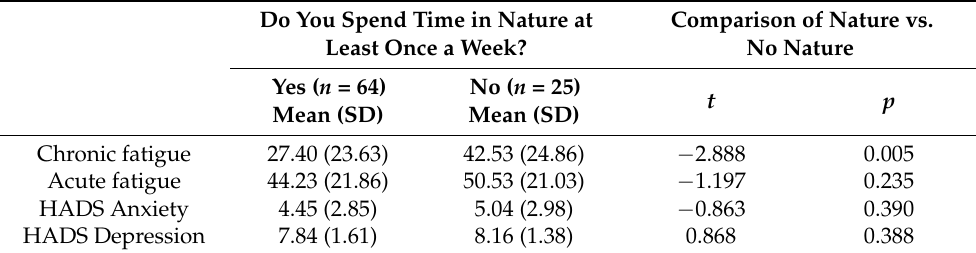
Table 2. Comparison of key outcome variables between participants who made weekly visits to nature, and those who did not. The results for chronic fatigue remain significant after applying a Bonferroni correction changes α to 0.05 ÷ 4 = 0.0125. HADS, Hospital Anxiety and Depression Scale. Do You Spend Time in Nature at Comparison of Nature vs. Least Once a Week? No Nature Yes ( n = 64) No ( n = 25) t p Mean (SD) Mean (SD) Chronic fatigue 27.40 (23.63) 42.53 (24.86) 0.005 Acute fatigue 44.23 (21.86) 50.53 (21.03) 0.235